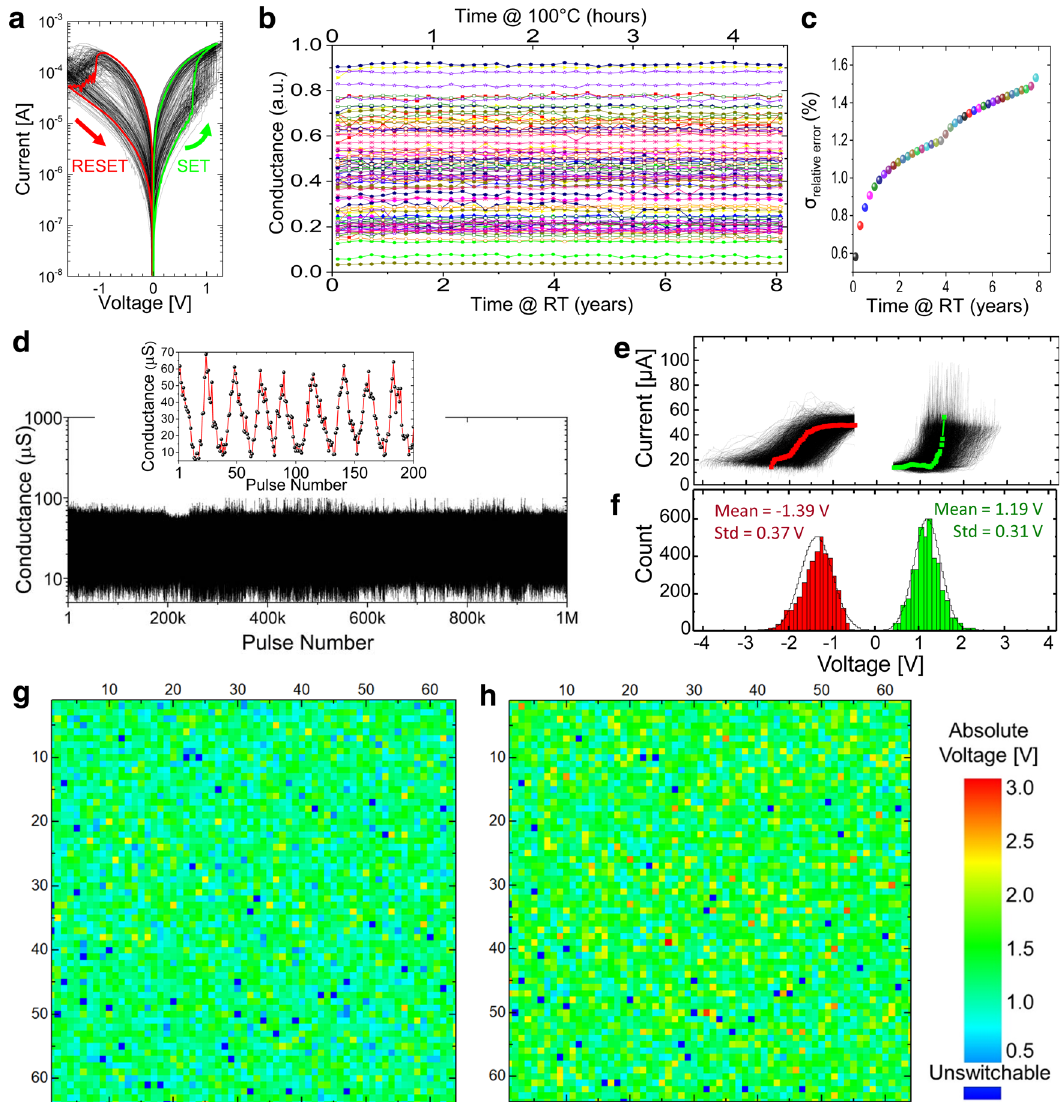
Fig. 2 Device characterization results. a Representative I – V curves, measured with quasi-static DC voltage sweeps, for the 36 formed devices of the 6 × 6 subarrays located in the center of the crossbar. For clarity, the curve for one particular device is highlighted. b Retention results for 10 different devices with data for each device shown with a speci fi c color. The tests for each device are performed 9 times with randomly chosen initial conductance. The evolution of the conductance was measured at 400 s intervals while continuously baking the crossbar circuit at 100 °C. c The standard deviation of the absolute conductance change normalized to G max = 62.5 µ S, i.e., 100% × | G initial − G fi nal |/ G max , as a function of the time interval for several ranges of initial conductances. Similar to panel b , the top axis corresponds to the measured retention data at 100 °C for 500 devices, with each device tested at 6 different initial states, while the bottom axis shows extrapolated results. For panels b and c, the bottom axes show extrapolated time at room temperature (RT) assuming 1.1 eV activation energy (see “ Methods ” section for details). d The switching endurance results for a crossbar device. The data are obtained by repeatedly applying alternative polarity sequences of 1-ms voltage pulses. The absolute amplitude of pulse in each sequence is initially 0.8 V and then ramped up with 0.1 V steps until the device reaches the extreme (i.e., on or off) state. Inset is a zoomed-in portion of the main panel, showing typical continuous switching during the endurance test. The device is switched about 10 5 times between its extreme states during the experiment. e Measured evolution of conductance upon application of increasing amplitude voltage pulses. All parameters of the utilized pulse sequences are similar to those shown in Fig. 3c inset, except for the 50 mV incremental step. f – h Extracted statistics of switching threshold voltages, de fi ned as the smallest absolute voltage at which device conductance, measured at 0.25 V, change by 20%, shown as ( f ) histogram and ( g , h ) voltage maps for ( g ) set and ( h ) reset transitions. The conductances are measured at 0.1 V for panels b – d fi gures. The forming voltages are only slightly higher on average memristors 17,24 . To electroform devices, a positive voltage is applied to the top electrode, while all unselected lines in the than set voltages and completely overlap for some, making such crossbar are fl oated 17 . Because of more extensive annealing devices effectively forming-free. The formed devices show similar compared to previous work 24 , the currents via as-fabricated magnitude set and reset voltages (Fig. 2a and Supplementary devices (Supplementary Fig. 4b) are just slightly less compared to Fig. 5b), from 200 µA to 400 µA reset and set switching currents, the device ’ s smallest (off-state) current after forming (Fig. 2a) — 2-µA-to-50-µA dynamic current range at 0.25 V, and balanced see, e.g., the highlighted curves for a speci fi c device in both I – V characteristics, i.e., I ( V ) ≈ − I ( − V ) at small voltages. The